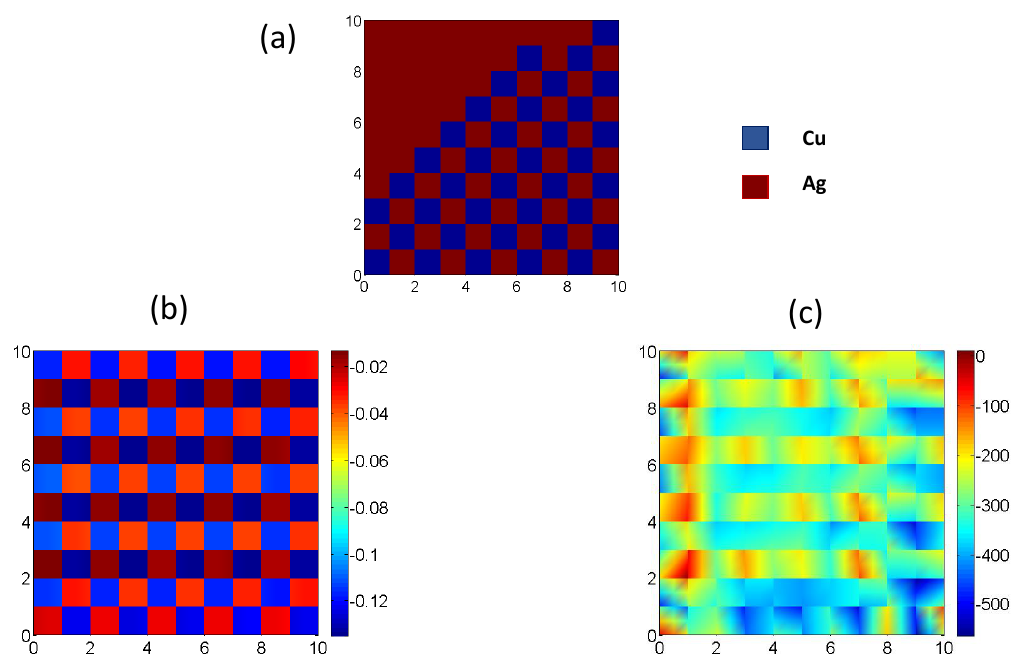
Figure 3. ( a ) Material distribution in the plane y 2 - y 3 at y 1 = D /9 i.e., ( N α = 2 ) on the examined cross-section; ( b ) the induced axial deformation gradient ( F 33 ) distribution in the plane y 2 - y 3 at y 1 = D /9, i.e., ( N α = 2 ) within the RUC of the large sample d 1 subjected to uniaxial compression loading; ( c ) the induced first Piola–Kirchhoff stress ( T 1 PK ) distribution in the plane y 2 - y 3 at y 1 = D /9, 33 i.e., ( N α = 2 ) within the RUC of the large sample d 1 .